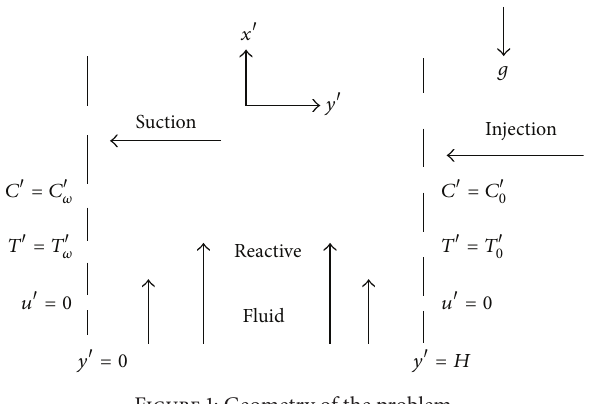
Figure 1: Geometry of the